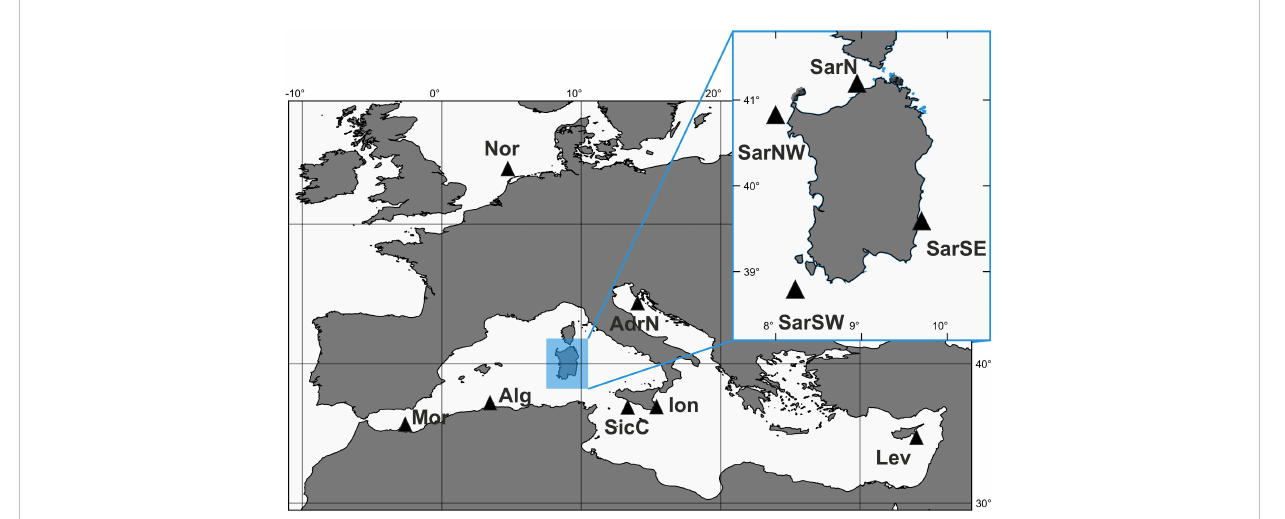
FIGURE 1 Sampling sites of Scyliorhinus canicula samples. SarSE, Sardinia South East; SarNE, Sardinia North East; SarNW, Sardinia North West; SarSW, Sardinia South West; AdrN, North Adriatic (Fano); Mor, Moroccan Coasts; Alg, Algerian Coasts; SicC, Sicilian Channel; Ion, Ionian Sea; Lev, Levantine Sea (Cyprus); Nor, North